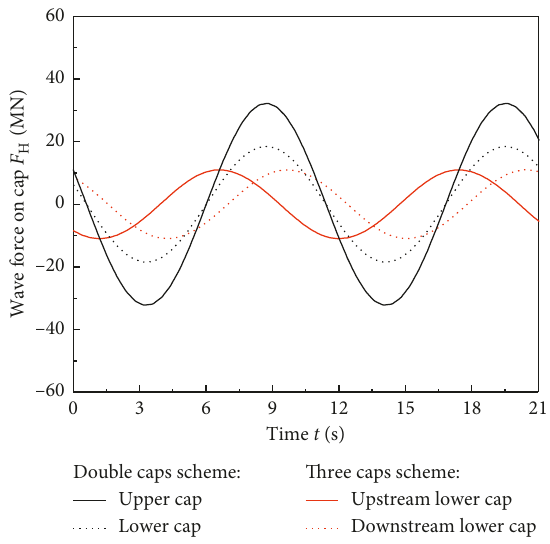
Figure 12: Wave forces on different